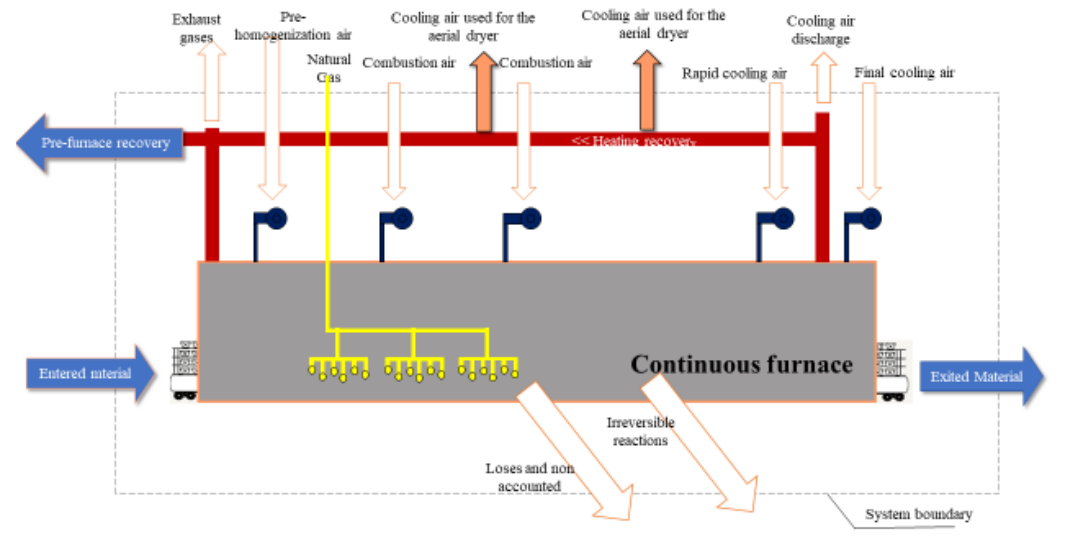
Figure 11. Thermodynamic system of the continuous furnace after the implementation of the measure.